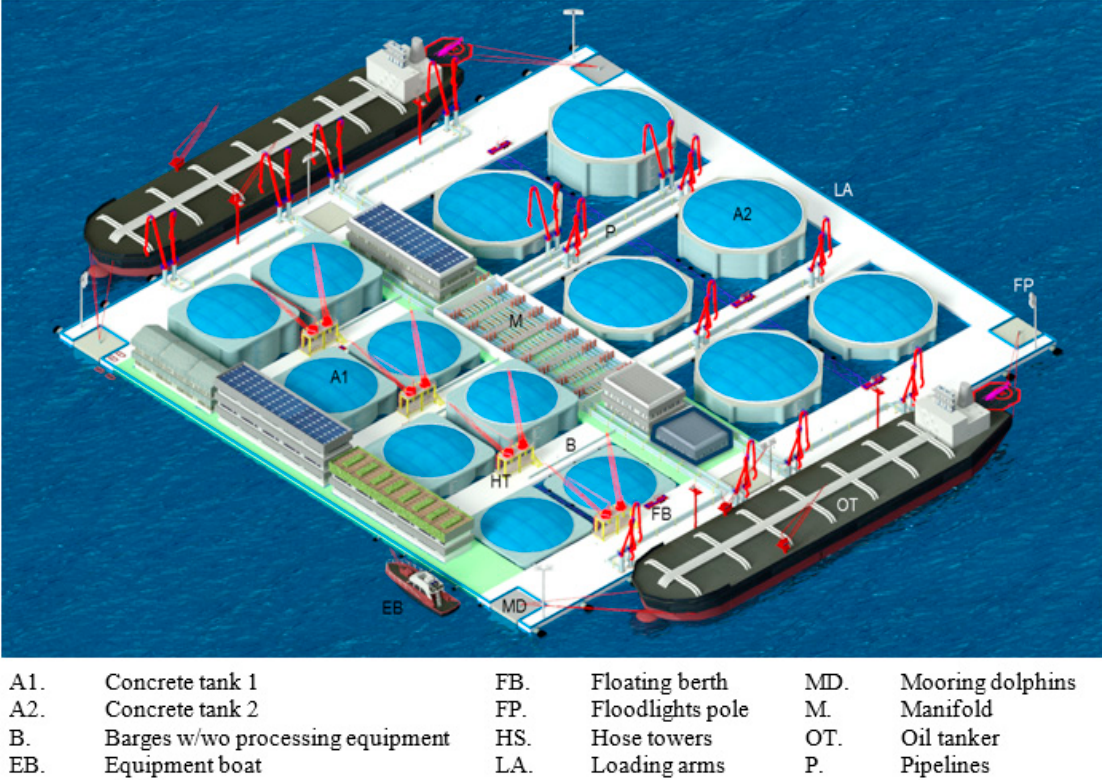
Figure 7. 3D architectural rendering view of FHSBF.